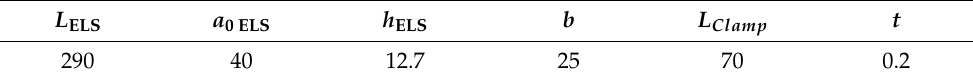
Table 3. Base geometrical parameters of the ELS specimen. Dimensions in millimetres. L ELS a 0